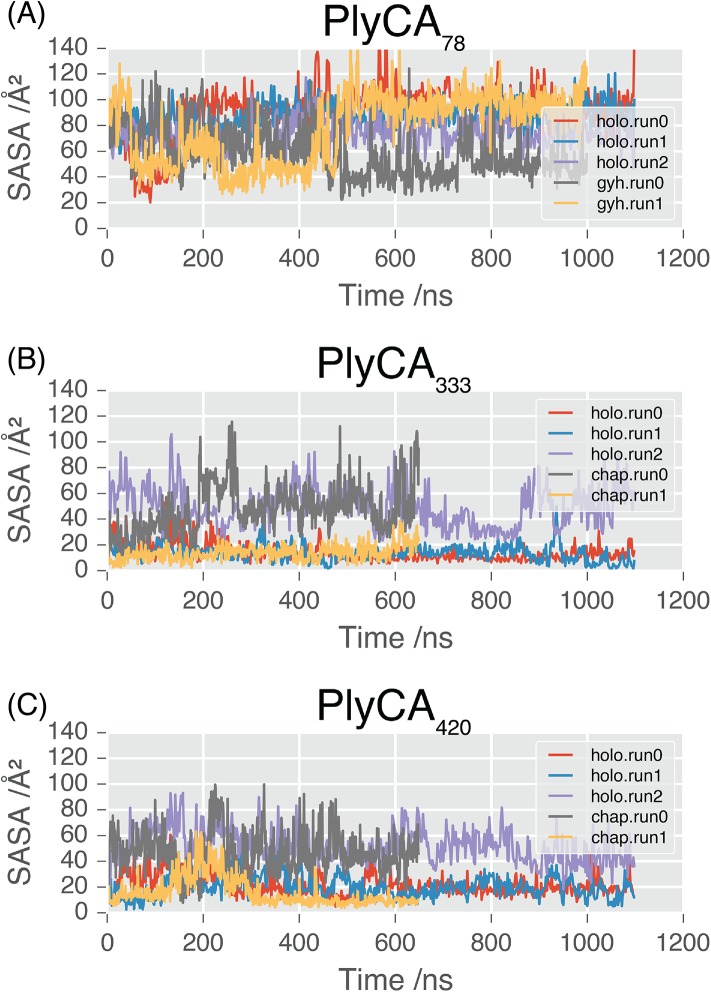
SASA of the catalytic residues in PlyC.Solvent accessible surface area associated with catalytic residues throughout simulation: (A) PlyCAE78, (B) PlyCAC333, (C) PlyCAH420.